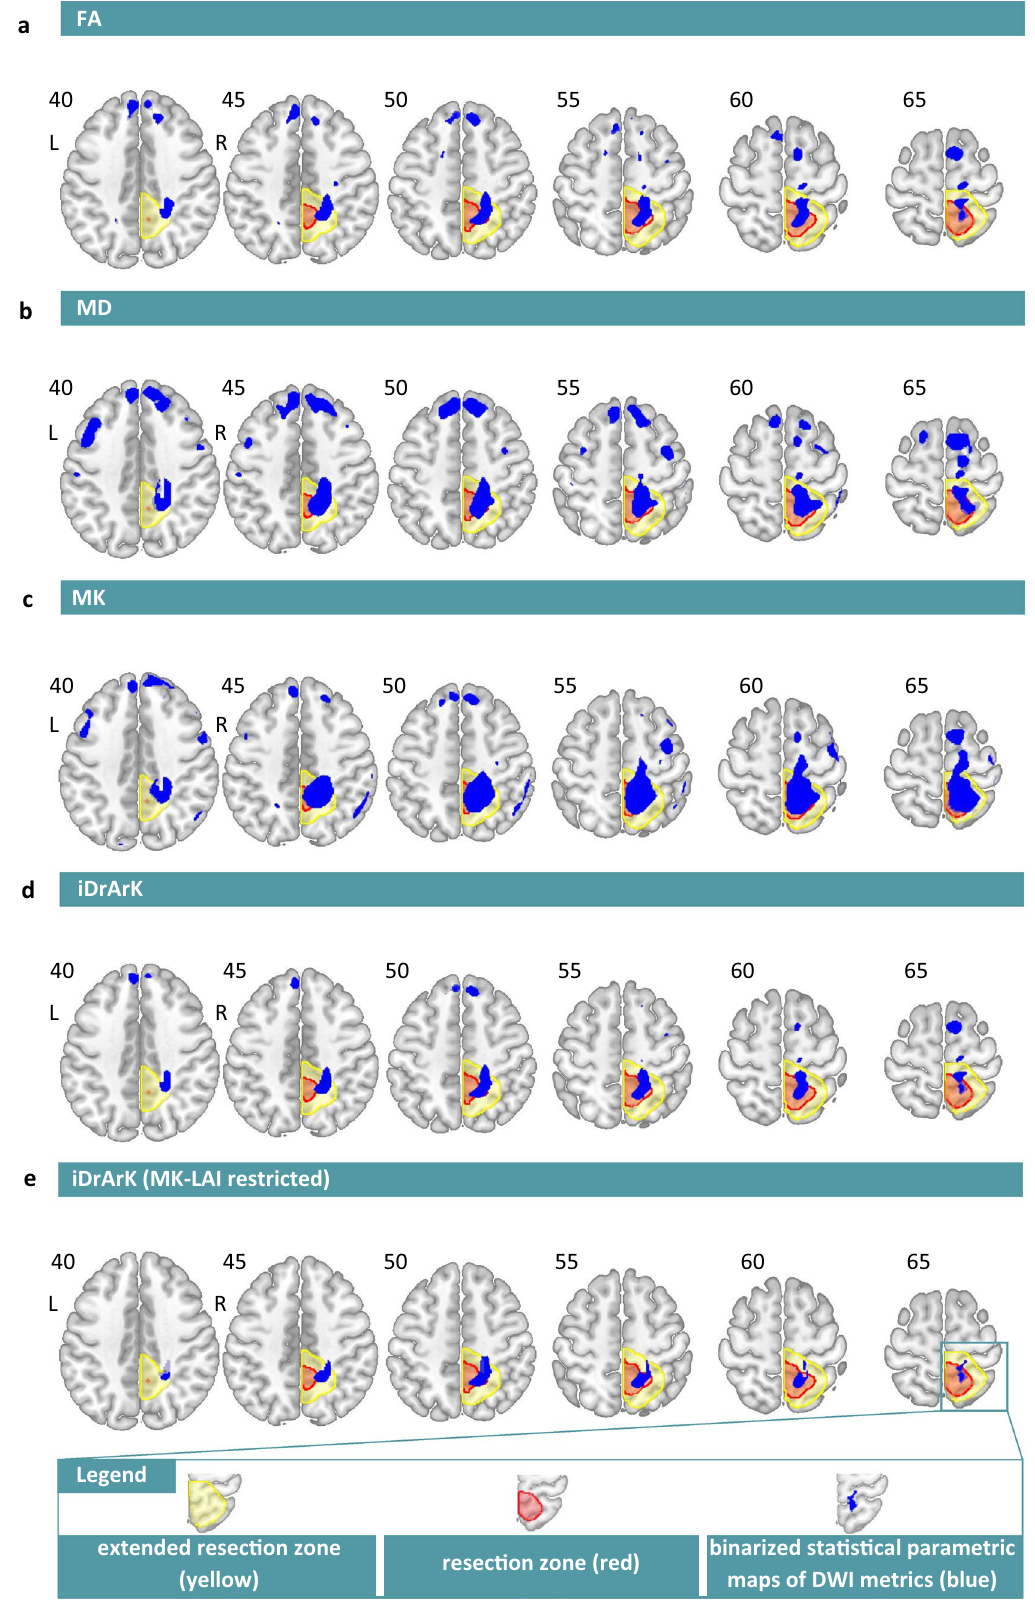
Figure 2. Example of binarized statistical parametric maps of DWI metrics (blue) for one subject. ( a ) FA– Fractional Anisotropy; ( b ) MD–Mean Diffusivity; ( c ) MK–Mean Kurtosis; ( d ) iDrArK–increased mean Diffusivity, reduced fractional Anisotropy, reduced mean Kurtosis; ( e ) iDrArK with MK-LAI–Lobar Asymmetry Index calculated from MK data restriction. Extended resection zone (light yellow); resection zone